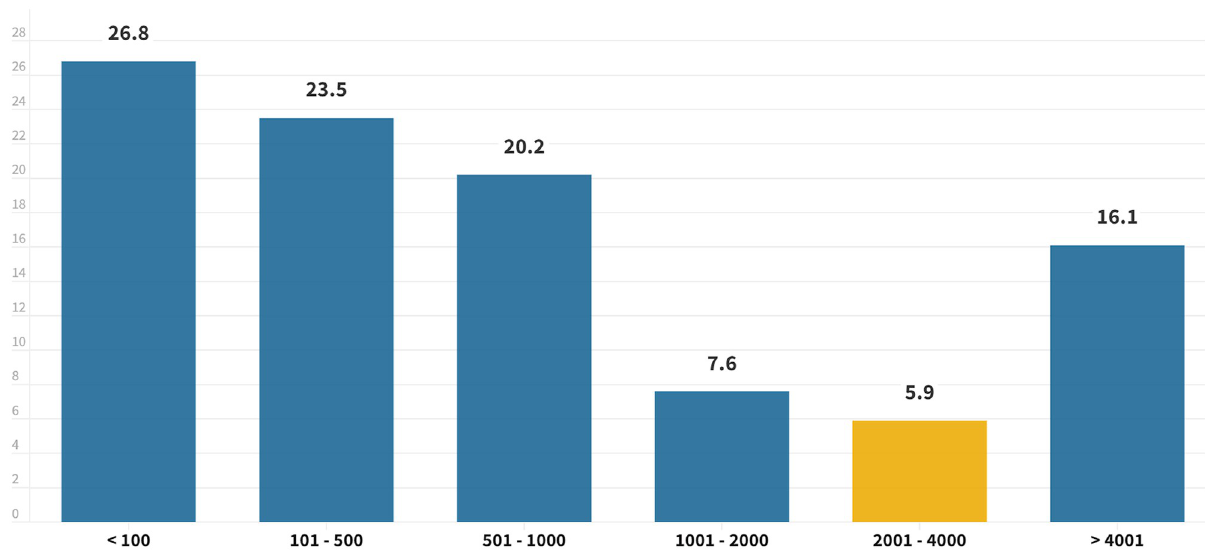
Fig 2. Number of yearly road fatalities estimated by study participants. The most common interval was 0–100, while it corresponds to 2001–4000